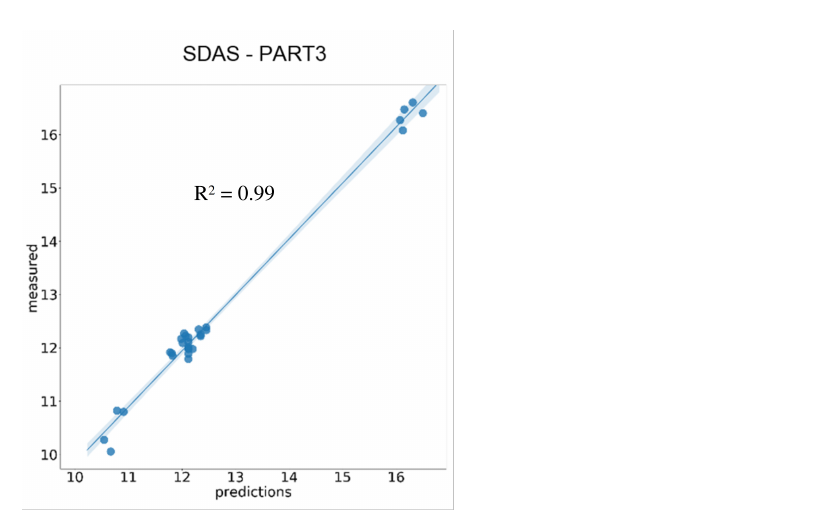
Figure 15. Examples of the results provided by the metamodels for misrun and shrinkage.